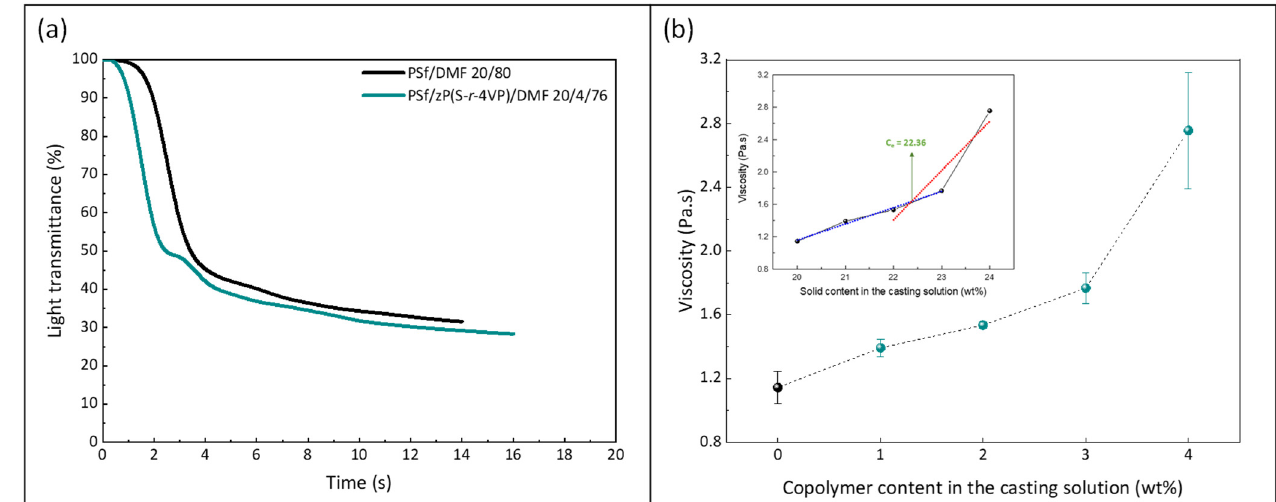
Figure 5. Effect of the copolymer on ( a ) kinetic of phase separation and ( b ) viscosity of the casting solution (0 wt% corresponds to the casting solution used to form the virgin membrane P20-Z0). Measurements performed at 25 °C. (Inset: determined chain entanglement concentration of the PSf/copolymer/DMF system).